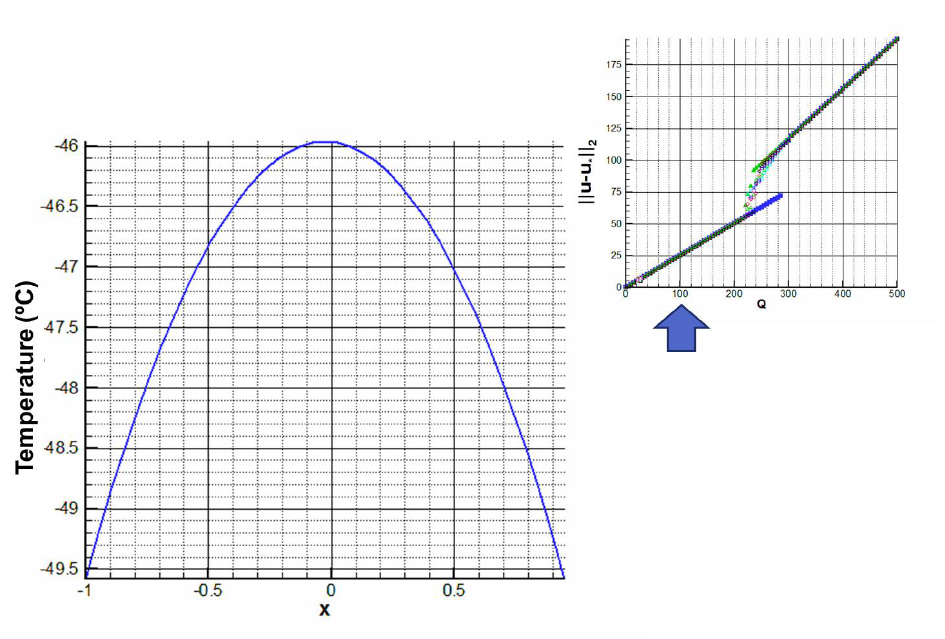
Figure 9. Unique stationary solution. Coupled model. Q = 100.